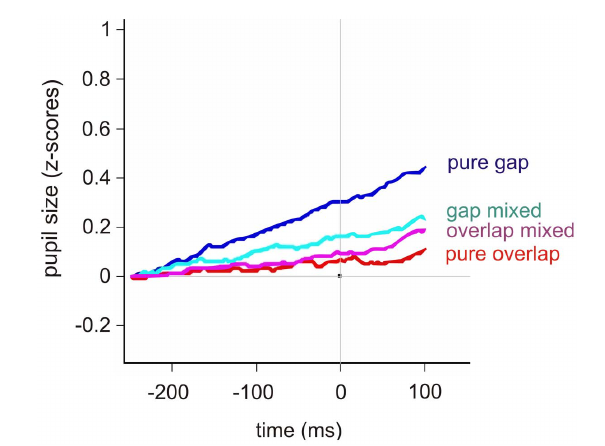
FIGURE 2 |Average pupil response ( z -scores) for the four different tasks: pure gap (blue), gap trials in mixed blocks (cyan), overlap trials in mixed blocks (pink), and pure overlap (red). The pupil response is plotted over time (ms); the considered time period [ − 250 100] includes the 50-ms after the end of the baseline period [ − 300 − 250] to give an idea of the starting level, the gap period [ − 200 0], i.e., the time window leading up to target onset, and the first 100ms after the target for the saccade was already presented.The latter period reflected half of the overlap time